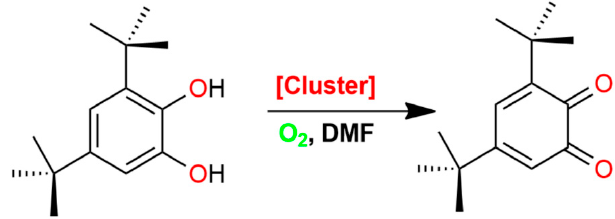
Scheme 2. Cluster catalytic oxidation of catechol to O-quinone.